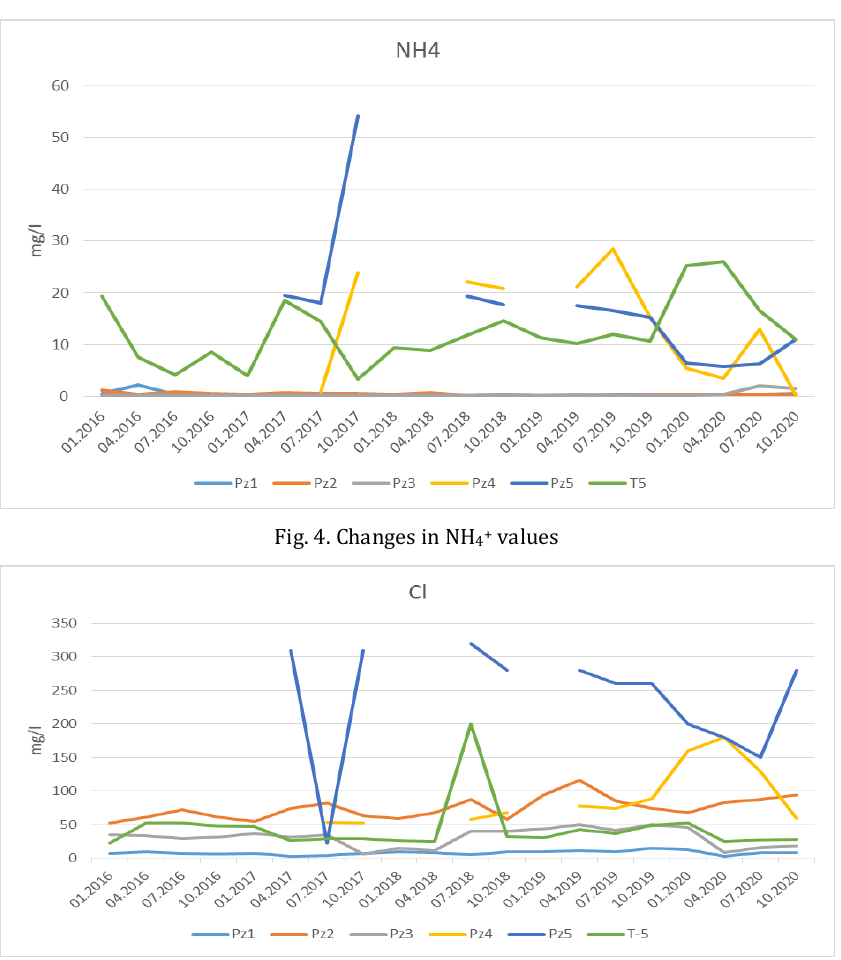
Fig. 5. Changes in Cl -